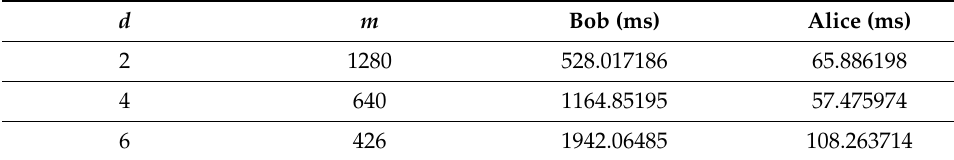
Table 9. Calculation times (ms) for Alice and Bob when n =